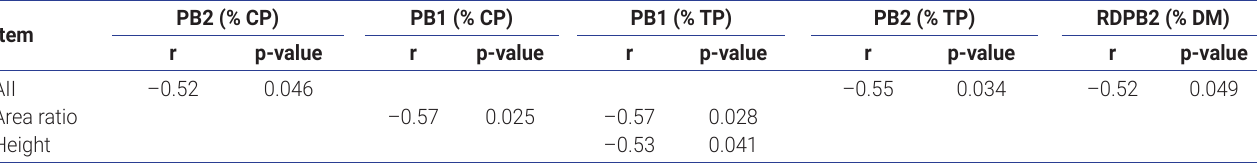
–0.57 Height –0.53 0.041 FTIR, Fourier transform infrared; CNCPS, Cornell Net Carbohydrate and Protein System; PB1, moderately degradable protein; CP, crude protein; PB2, slowly degradable protein; TP, true protein; RD, rumen degradable; AII, Amide II area; Area ratio, ratios of amide I and amide II areas; Height, ratios of amide I and II heights; r, correlation coefficient using